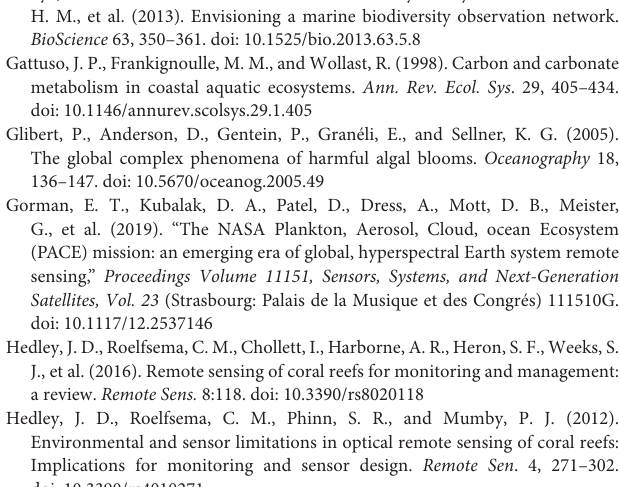
algorithm development, validation, and verification. One